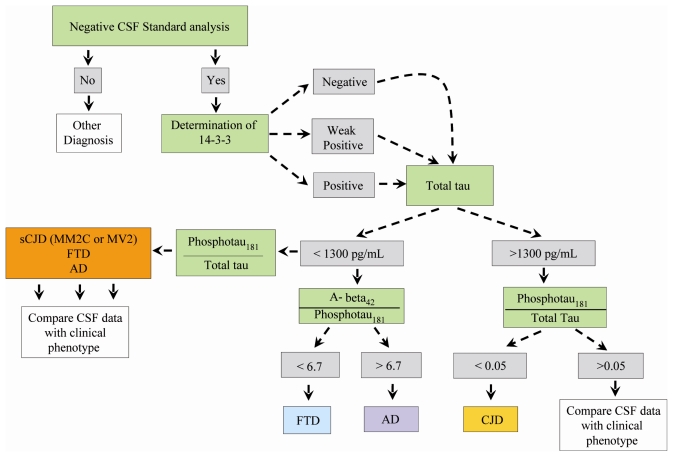
Chart for diagnosis of sCJD versus FTD and AD.